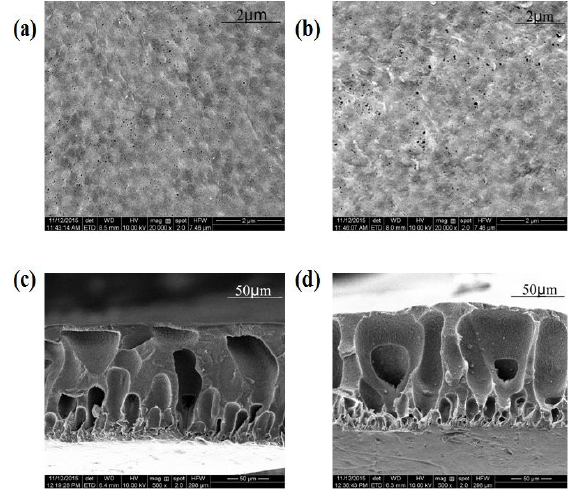
Figure 2. SEM images of composite PVDF membranes: ( a ) surface of PVDF-PVP membrane 20000×; ( b ) surface of PVDF-PVP-TiO 2 membrane 20000×; ( c ) cross-section of PVDF-PVP membrane 500×; ( b ) surface of PVDF-PVP-TiO 2 membrane 20,000 ˆ ; ( c ) cross-section of PVDF-PVP membrane 500 ˆ ; ( d ) cross-section of PVDF-PVP-TiO 2 membrane 500×. ( d ) cross-section of PVDF-PVP-TiO 2 membrane 500 ˆ